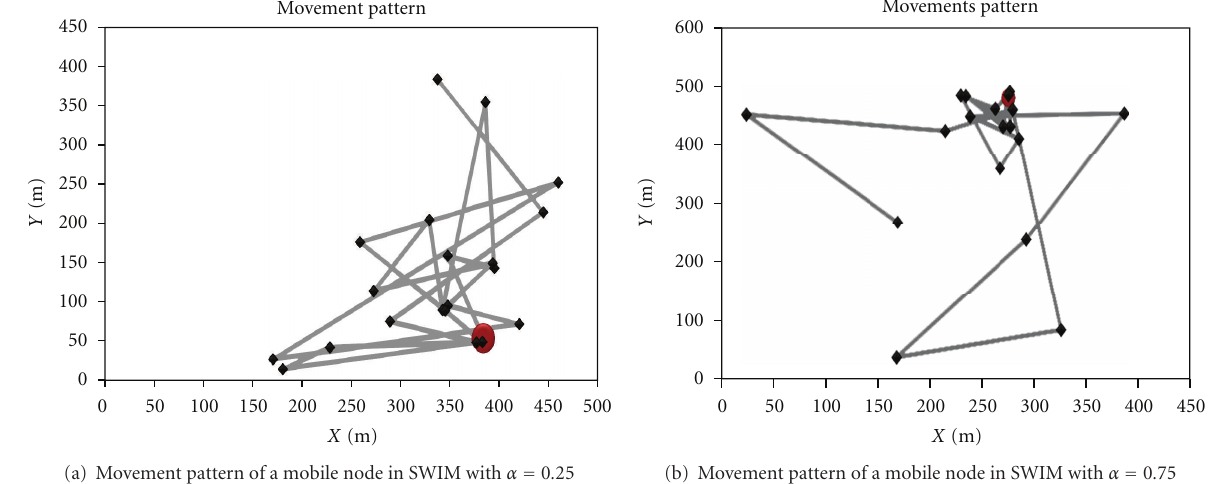
Figure 5: Example movement patterns in SWIM for di ff erent values of α .